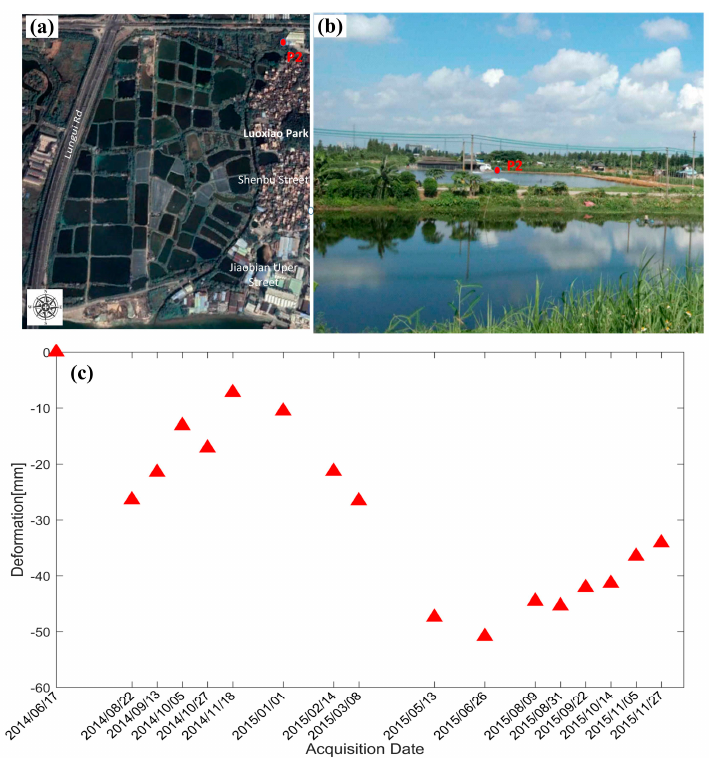
Figure 21. Time series analysis on point P1 (referenced to 2014/06/17): ( a ) the location of P1 on Google earth optical image; ( b ) in-situ picture (download online) of location P1; ( c ) time series deformation evolution over P1.